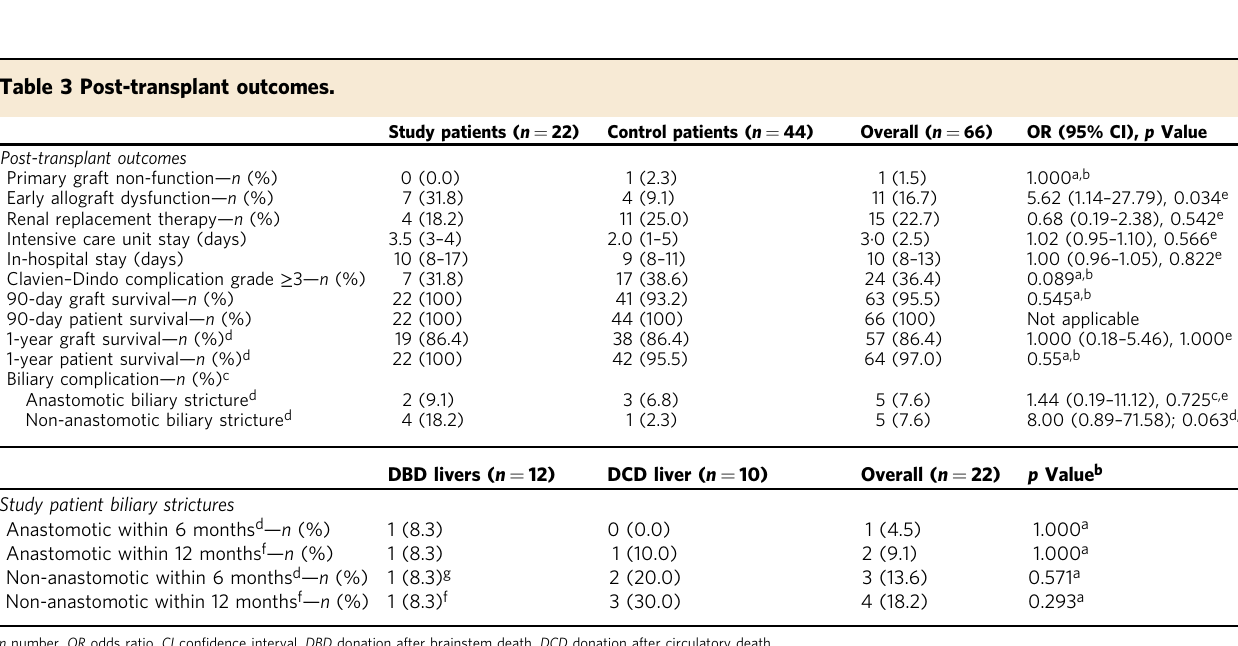
Table 3 Post-transplant